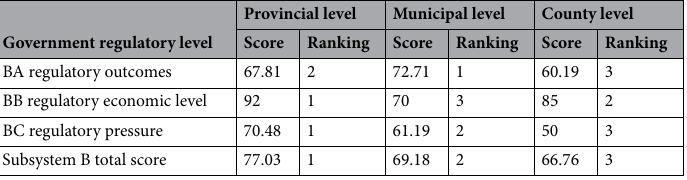
Table 8. Score ranking of supervision effect (subsystem B) of three-level supervision departments in provinces, cities, and counties.